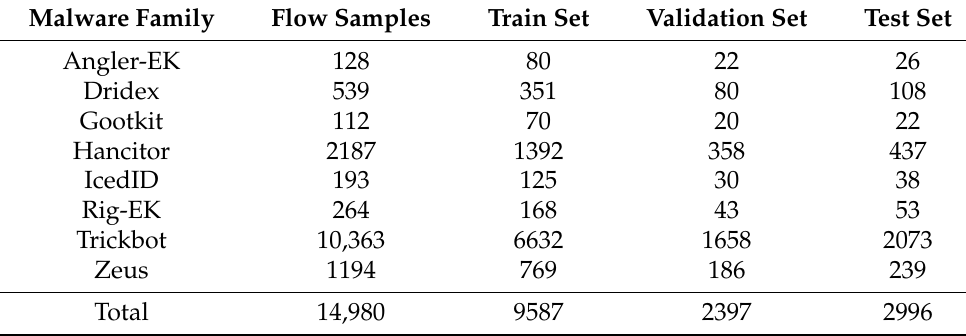
Table 1. Flow samples of malware families used in